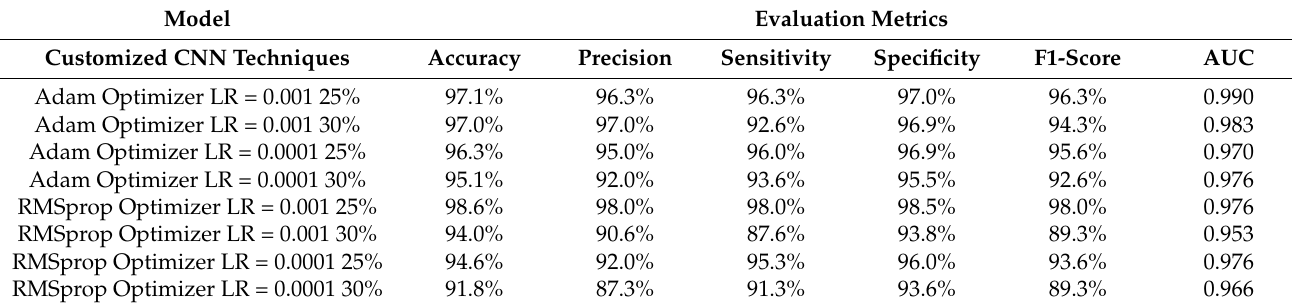
Table 2. The evaluation metrics of three classes averaged with our customized CNN